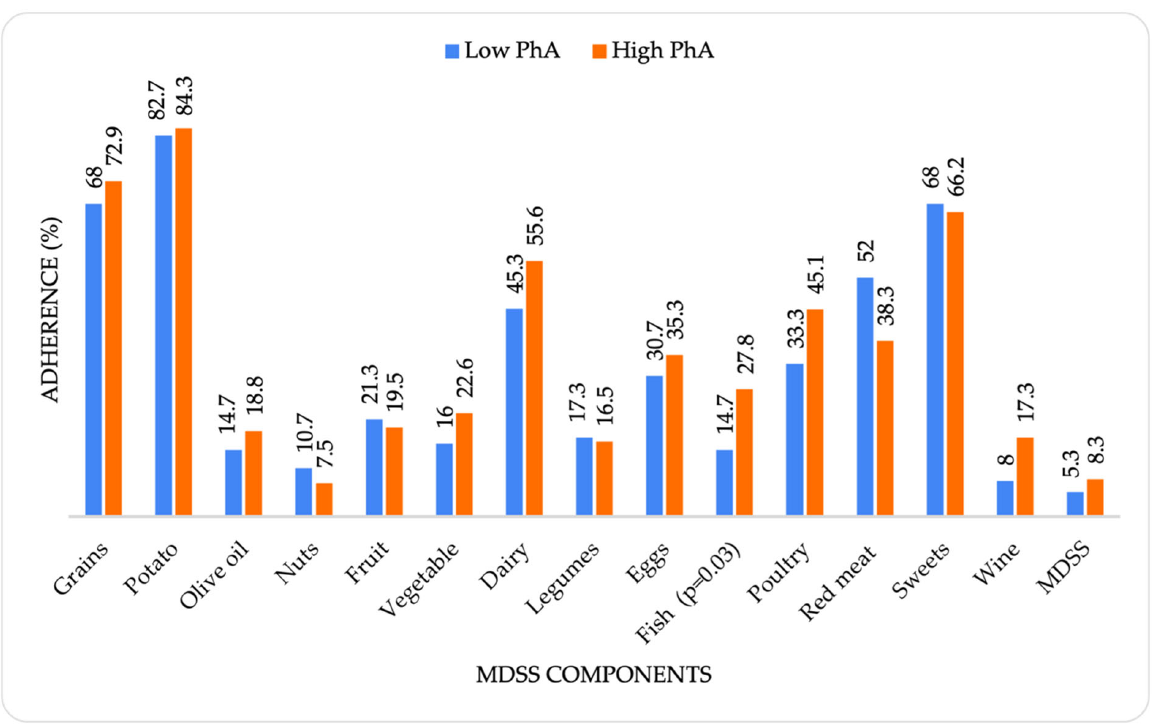
Figure 3. Adherence to the MeDi considering phase angle values. Table 3. Correlations between phase-angle and measured parameters (only statistically significant correlations are shown). Significant positive correlations were found for WC ( p = 0.004); pDBP ( p = 0.01); fat ‐ free mass ( p < 0.001); muscle mass (kg; p = 0.01 and